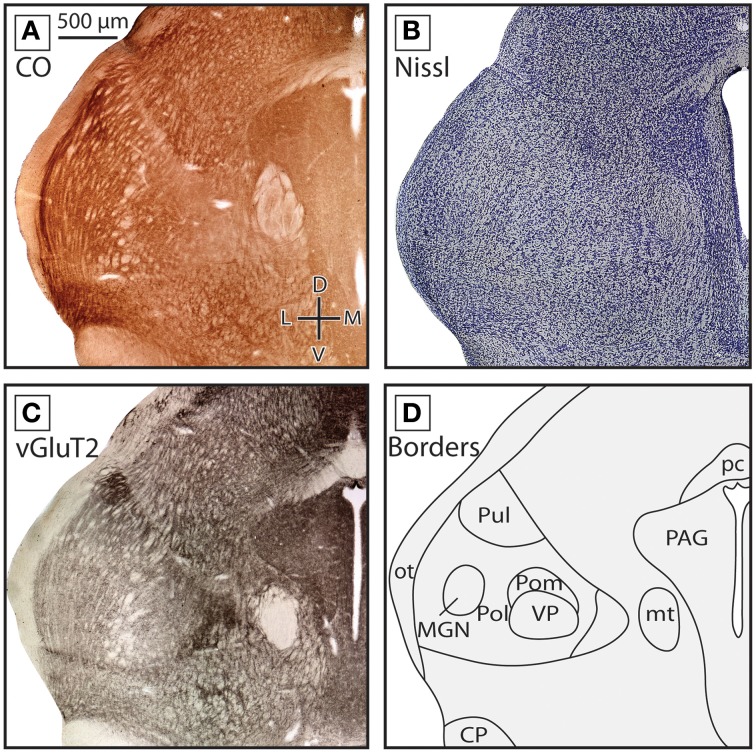
Boundaries of nuclei in the dorsal thalamus at the caudal-most extent of the ventral posterior nucleus in the short-tailed opossum. All three stains used are the same in Figures 3, 4, along with an illustration of nuclear boundaries. In these sections VP, Pol and MG can be identified. Pol is lateral to VP and extends outward, surrounding the emerging MGN. Conventions as in previous two figures.